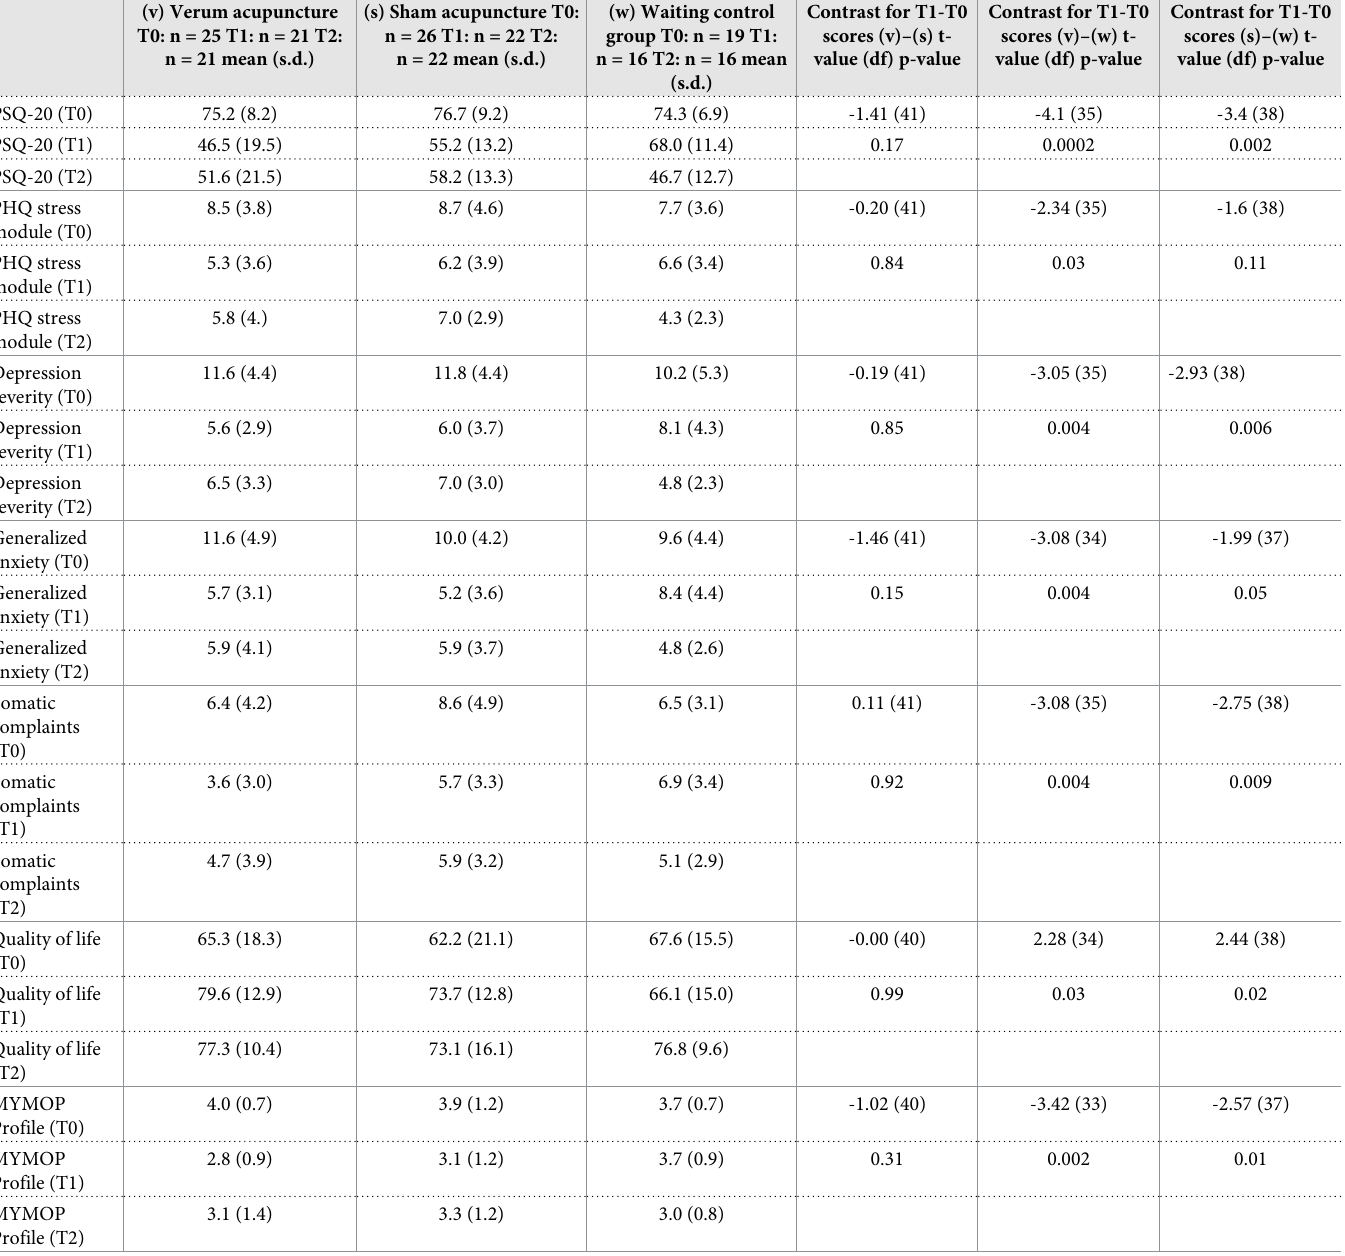
Table 2. Mean values for the PSQ-20 and further stress-related variables at three time points. (v) Verum acupuncture T0: n = 25 T1: n = 21